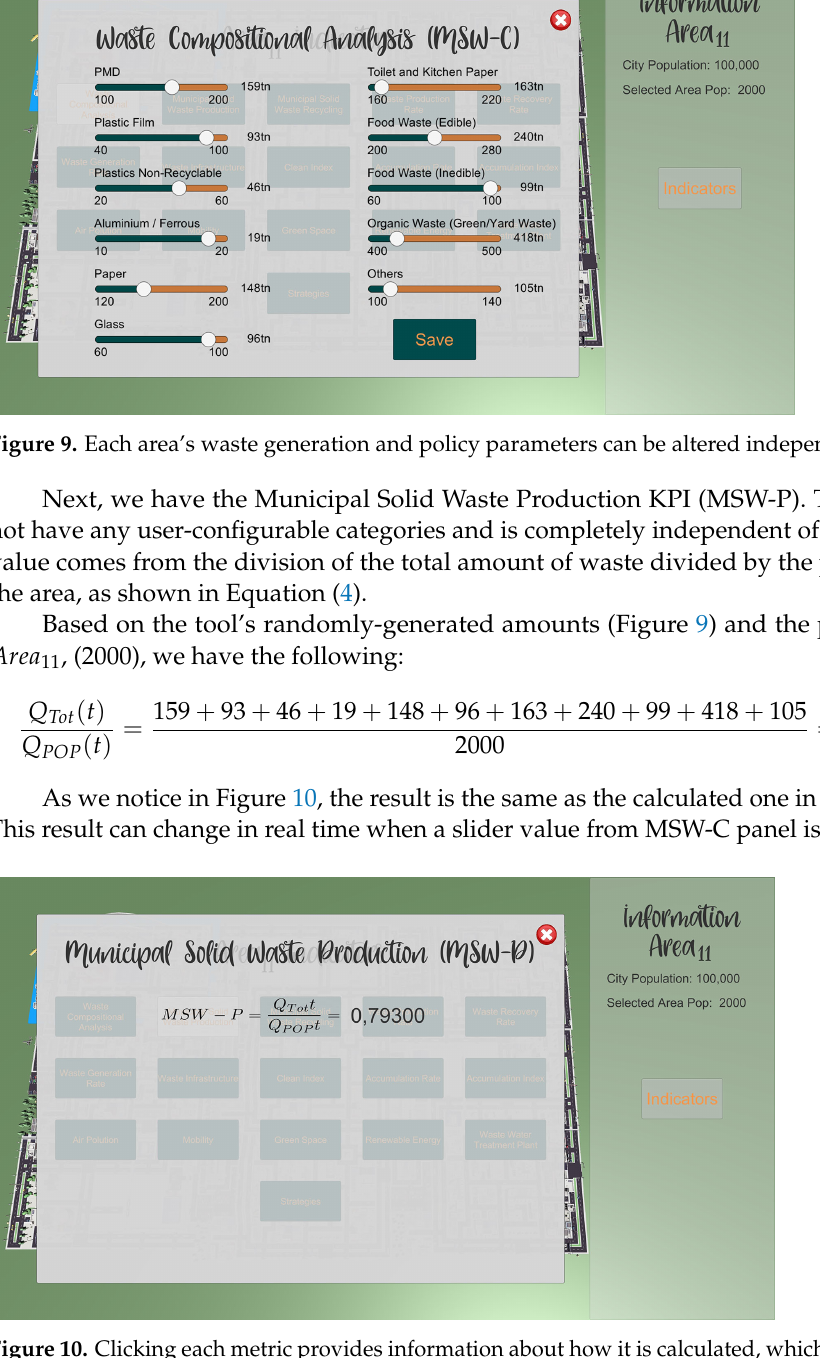
Figure 10. Clicking each metric provides information about how it is calculated, which helps students learn to create effective management policies. These indicators reflect the parameters as identified in Section 3 (note that due to regional differences, the figure shows a comma rather than a period in the numeric